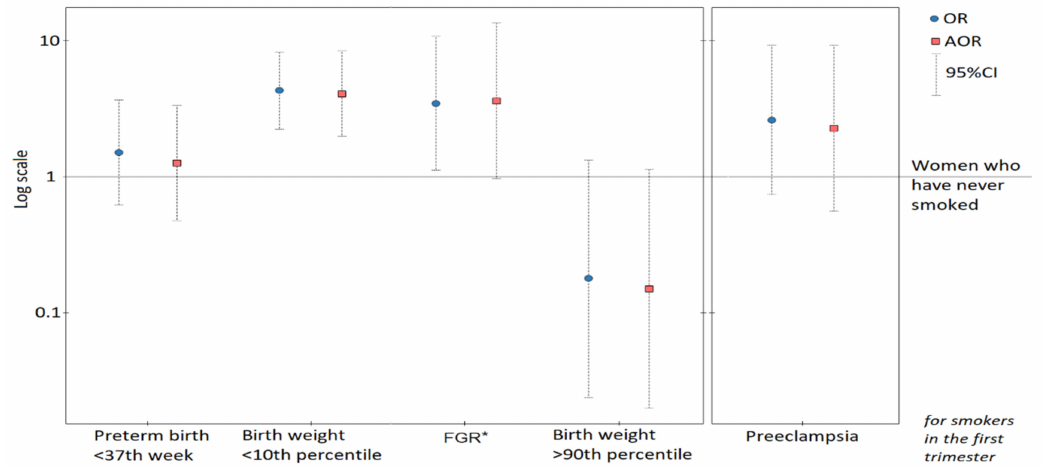
Figure 2. Odds ratios (and 95% confidence intervals) of newborn outcomes (and preeclampsia) for smoking in the 1st trimester. The graphs are presented on a logarithmic scale. The adjusted odds ratios (AOR) were calculated after adjusting for primiparous women, maternal age, pre-pregnancy BMI as well as gestational weight gain outside the range. *FGR: fetal growth